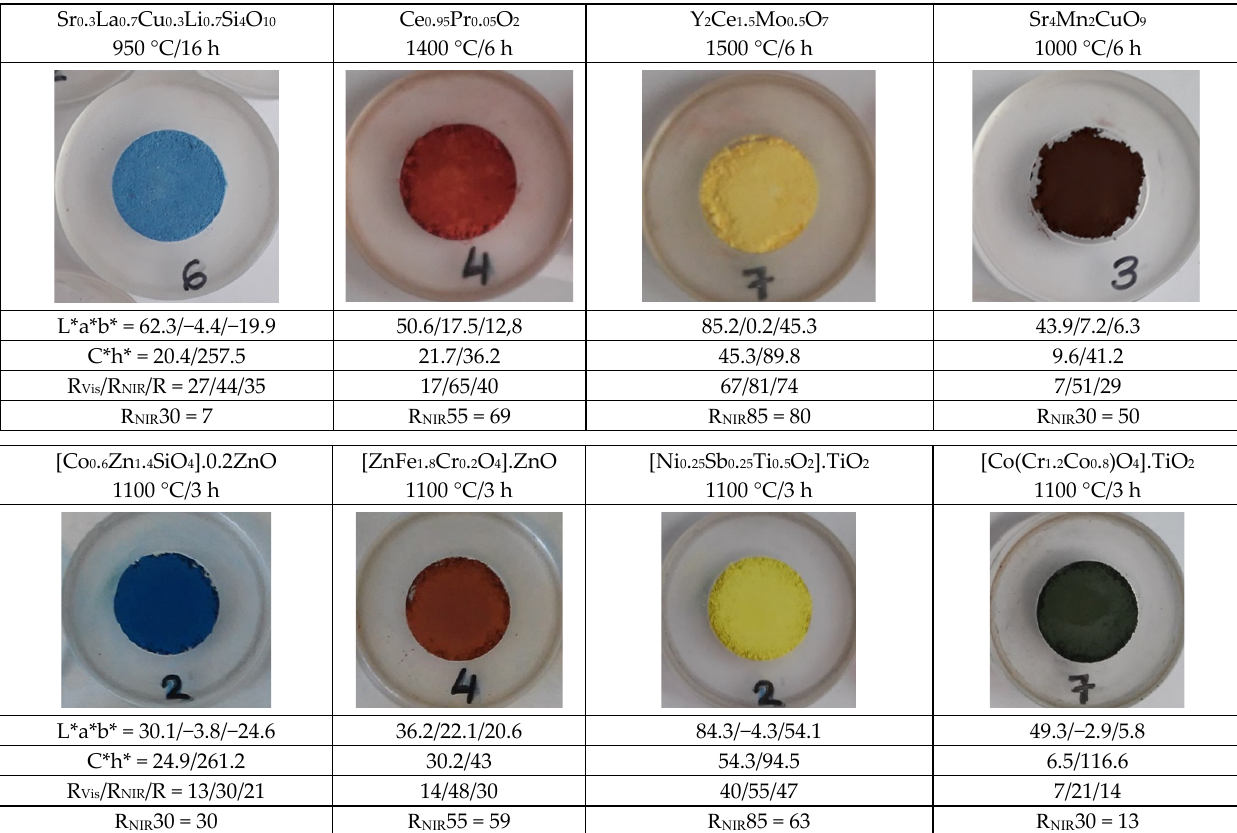
Figure 6. Image of the powders, colour and its colorimetry (L*a*b* and C*h*) and reflectance parameters (R Vis /R NIR /R). Table 2. Colorimetry and reflectance parameter for CaCO 3 addition to blue